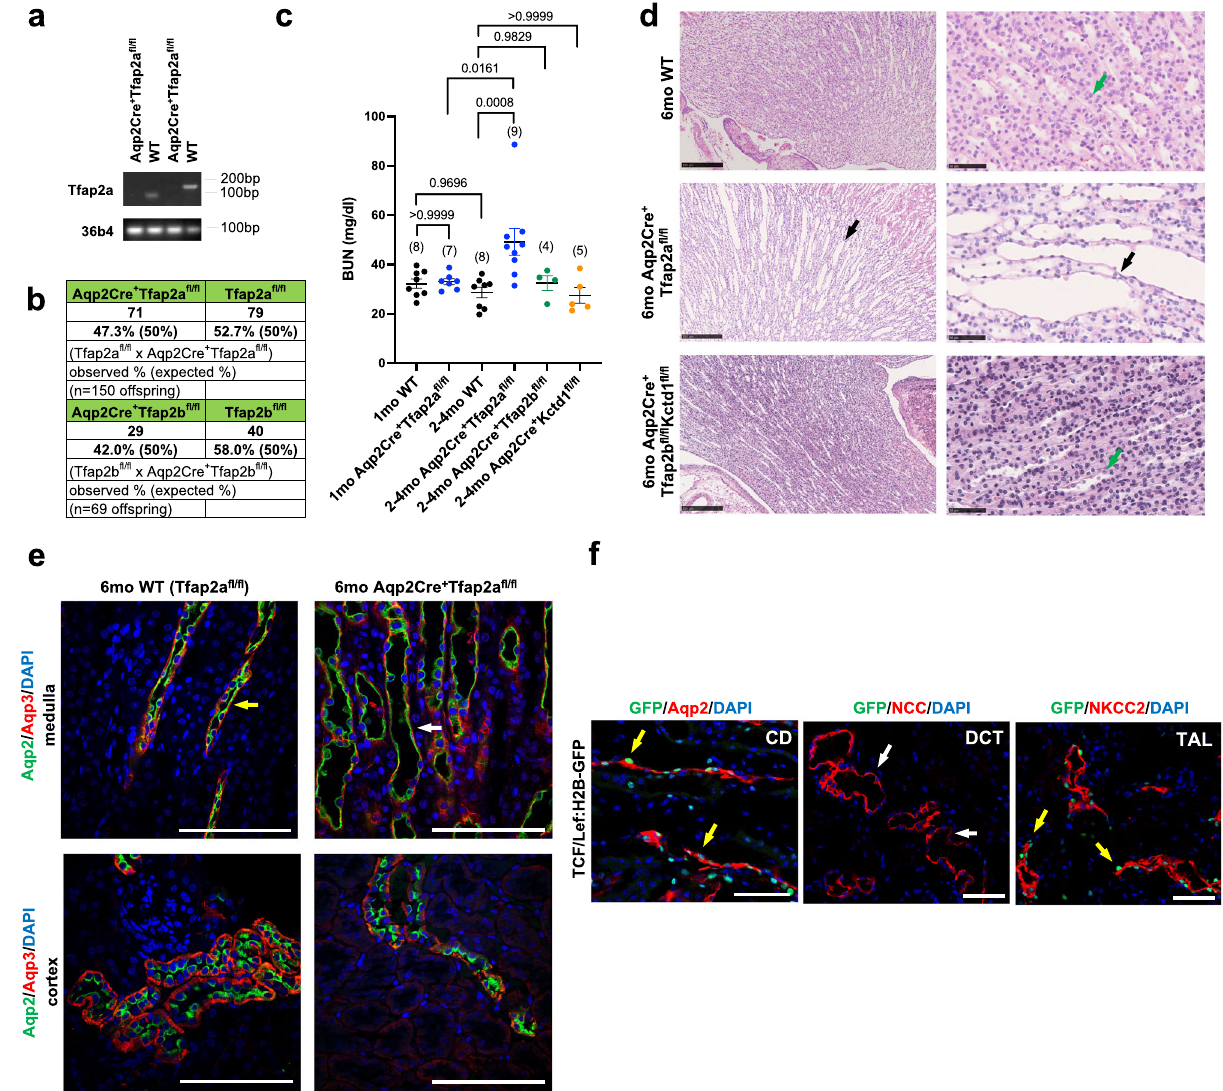
Fig. 2 AP-2 α regulates medullary CD structure in the adult but is not required for CD development. a RT-PCR of whole kidney lysates of Aqp2Cre + Tfap2a fl / fl mice and Cre-negative littermates (WT) with two different PCR primer pairs that span exons 5/6 of Tfap2a . Kidneys of Aqp2Cre + Tfap2a fl / fl mice show ef fi cient inactivation of Tfap2a . 36b4 housekeeping gene. DNA ladder band size is indicated. b Aqp2Cre + Tfap2a fl / fl mice and Aqp2Cre + Tfap2b fl / fl mice show a normal Mendelian ratio at 4-weeks of age. c Serum BUN levels are normal in 1-month-old Aqp2Cre + Tfap2a fl / fl mice but they are increased at 2 – 4 months of age, whereas at that age BUN levels remain normal in Aqp2Cre + Tfap2b fl / fl mice or Aqp2Cre + KCTD1 fl / fl mice. Adjusted p values are shown (one-way ANOVA with Tukey ’ s multiple comparisons test). Graphs represent data as mean ± SEM. Number of mice per group is indicated in brackets. Source data are provided as a Source Data File. d Dilated medullary CDs with fl attened epithelial cells (black arrows) in 6-months-old Aqp2Cre + Tfap2a fl / fl mice, but not in WT littermates (Tfap2a fl / fl mice) or Aqp2Cre + Tfap2b fl / fl Kctd1 fl / fl mice (green arrows). Scale bars, 250 μ m left, and 50 μ m right. e Immunolabeling for Aqp2 and Aqp3 show dilated medullary CDs in 6-months-old Aqp2Cre + Tfap2a fl / fl mice (white arrow) compared to WT littermates (yellow arrow), whereas cortical CDs/CTs appear normal. Scale bars, 100 μ m. f TCF/Lef:H2B-GFP mice serve as reporter mice for cellular β -catenin activity (GFP + cells): GFP + cells (yellow arrows) are detected in CDs (Aqp2 + ) in the medulla as well as in TALs (NKCC2 + ), whereas DCTs (NCC + ) show no GFP + cells (white arrows). 23-months-old TCF/Lef:H2B-GFP mouse kidney. Scale bars, 50 μ